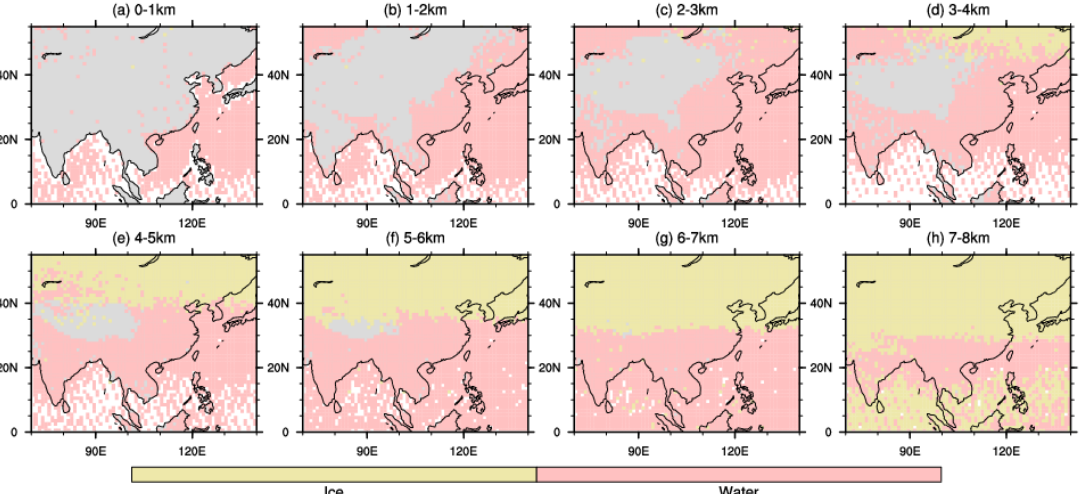
Figure 9. Prevailing cloud phases at different altitude layers: ( a ) 0–1 km, ( b ) 1–2 km, ( c ) 2–3 km, ( d ) 3–4 km, ( e ) 4–5 km, ( f ) 5–6 km, ( g ) 6–7 km and ( h ) 7–8 km.